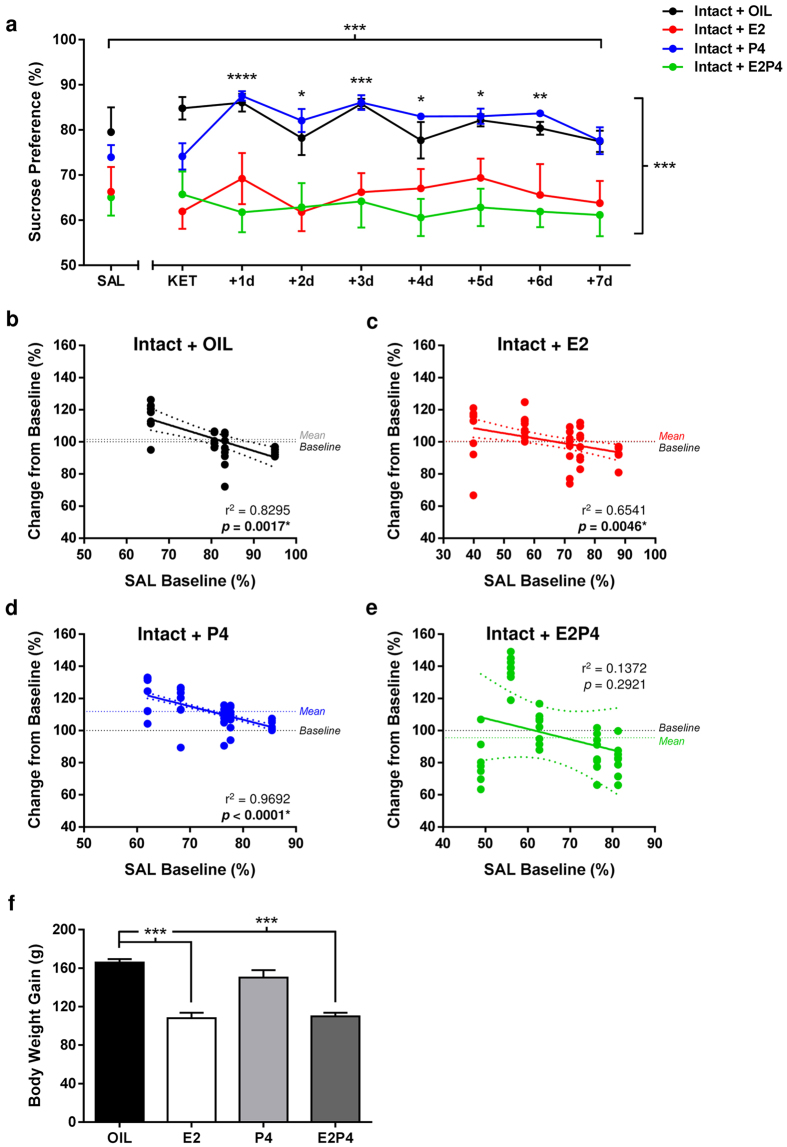
Cyclic P4 treatment enhances the hedonic sensitivity of intact male rats to low-dose ketamine.(a) Cyclic P4 treatment increased sensitivity of male rats to low-dose ketamine (KET) treatment (****p < 0.0001, ***p < 0.001, **p < 0.01, *p < 0.05 vs. SAL) for up to 6 days following drug administration (Main Effects: Treatment/Day, ***p < 0.001; Hormone: ***p < 0.001). Data are expressed as mean ± SEM (n = 40). (b–e) Lower saline (SAL) baseline sucrose preference levels predicted a higher magnitude of positive response to KET in treatment-responsive P4-treated intact males (r2 = 0.9692, P < 0.0001). (f) Cyclic treatment with E2 alone or in combination with P4 significantly reduced overall body weight gain of intact male rats compared to Intact + OIL males (***P < 0.001), confirming effective hormone treatment. Data are expressed as mean ± SEM (n = 38).